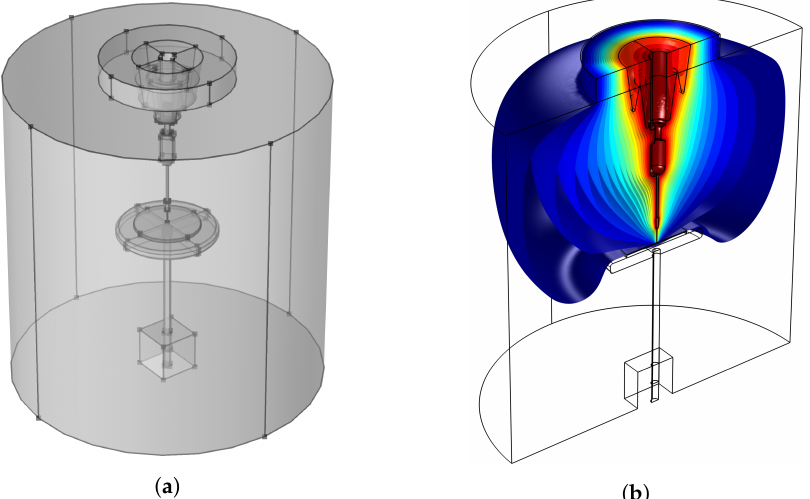
Figure 2. Finite Element Method (FEM) simulation model: ( a ) Full geometry including electrodes arrangement and surrounding volume; ( b ) Three-dimensional equipotential surfaces (isosurfaces) within the half symmetrical volume of the initial